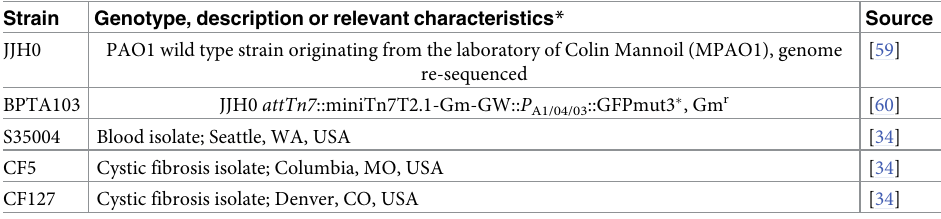
Table 1. Pseudomonas aeruginosa strains and isolates used in this